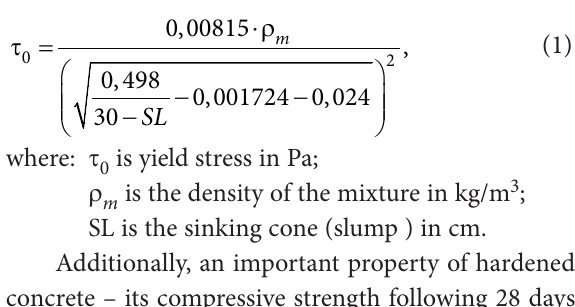
Table 5. The composition of concrete mixtures Amounts of materials in 1m 3 of the concrete mixture, kg